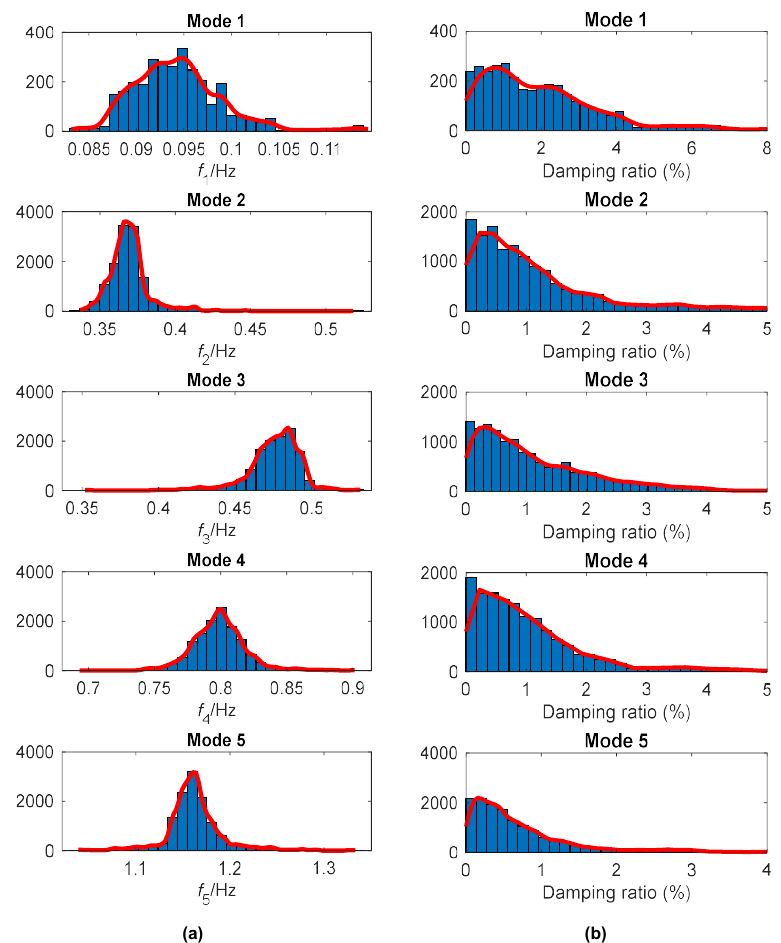
Figure 11. Histograms for the instantaneous modal parameters of Canton Tower identified by EWT: ( a )